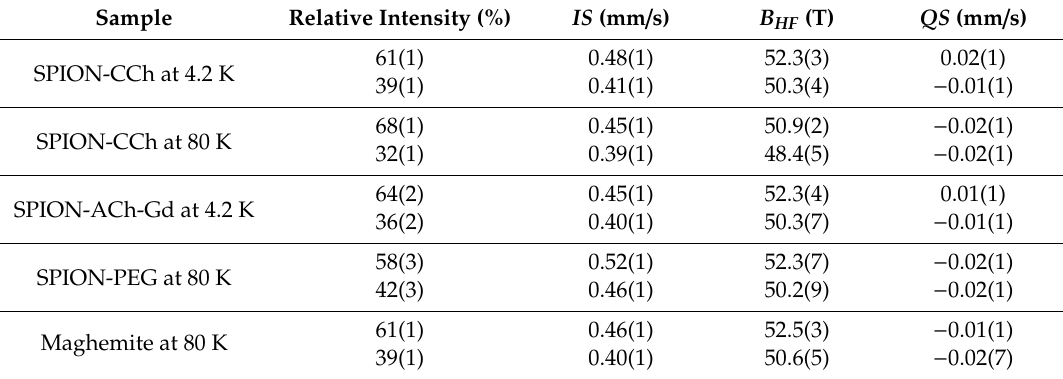
Table 3. Hyperfine parameters for the studied nanoparticles and microcrystalline maghemite obtained from the fit at low temperature (4.2 K and 80 K) of Mössbauer spectra.